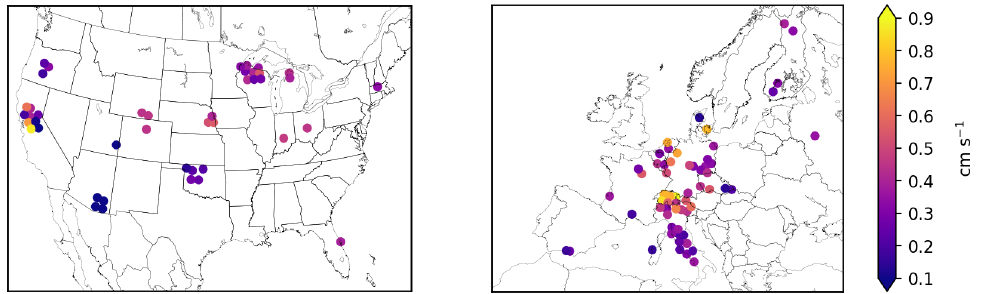
Figure 1. Mean stomatal conductance for O 3 (g s ) during daytime in the growing season at FLUXNET2015 sites in the United States and Europe. Symbols of some sites have been moved slightly to reduce overlap and improve